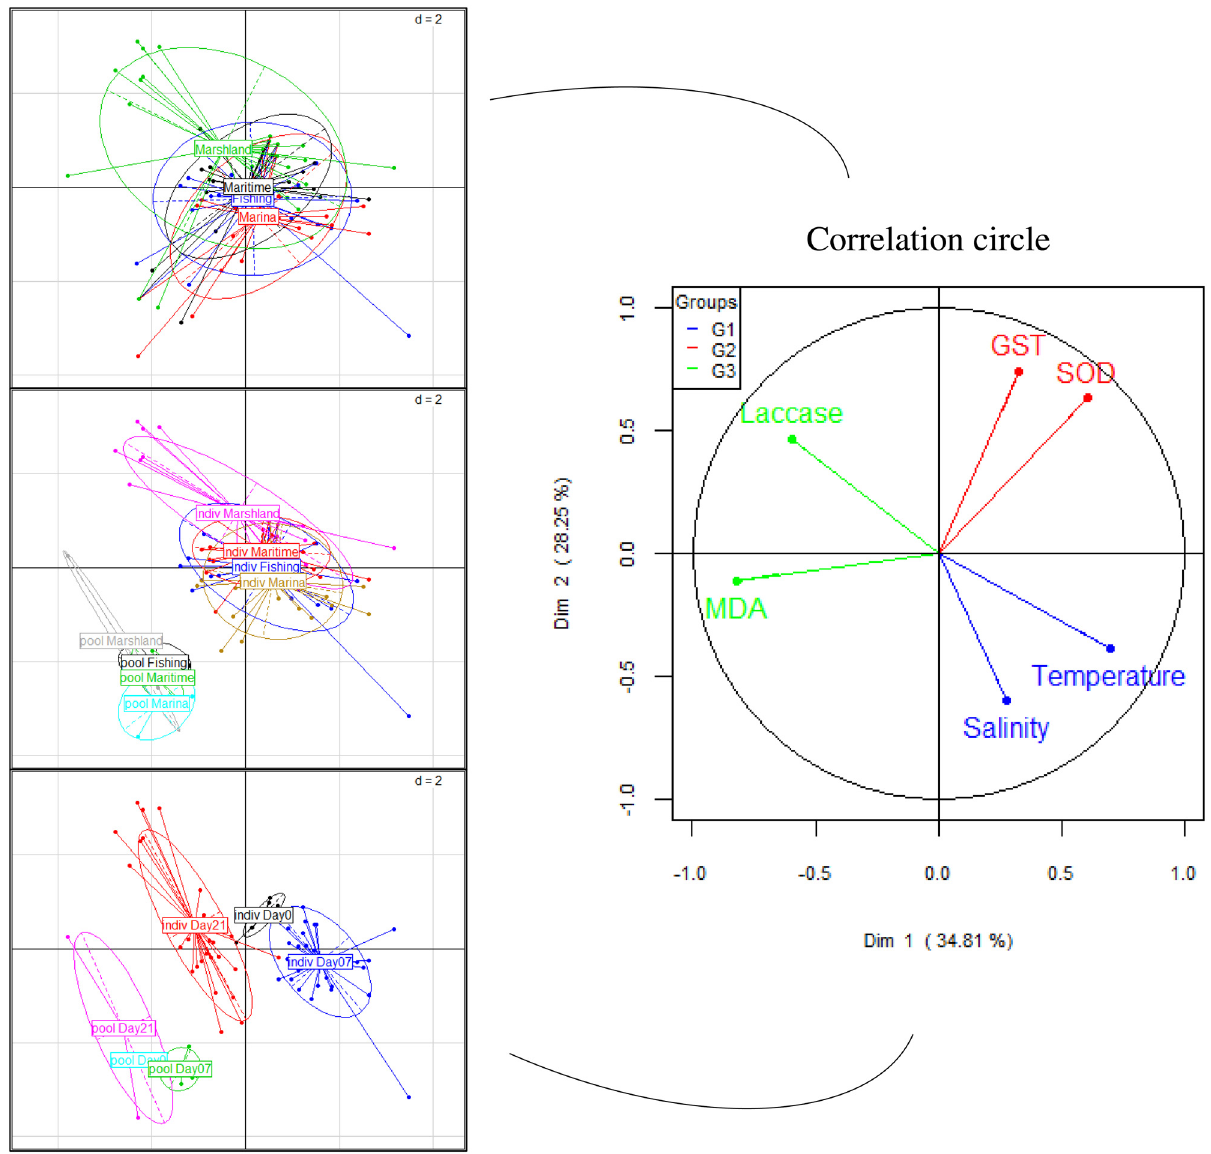
Fig 5. Two-dimensional graph (axes 1 and 2) including the circle of correlations (on the right), the scatter plots comparing each site, the analysis techniques, and the sampling dates (on the left).